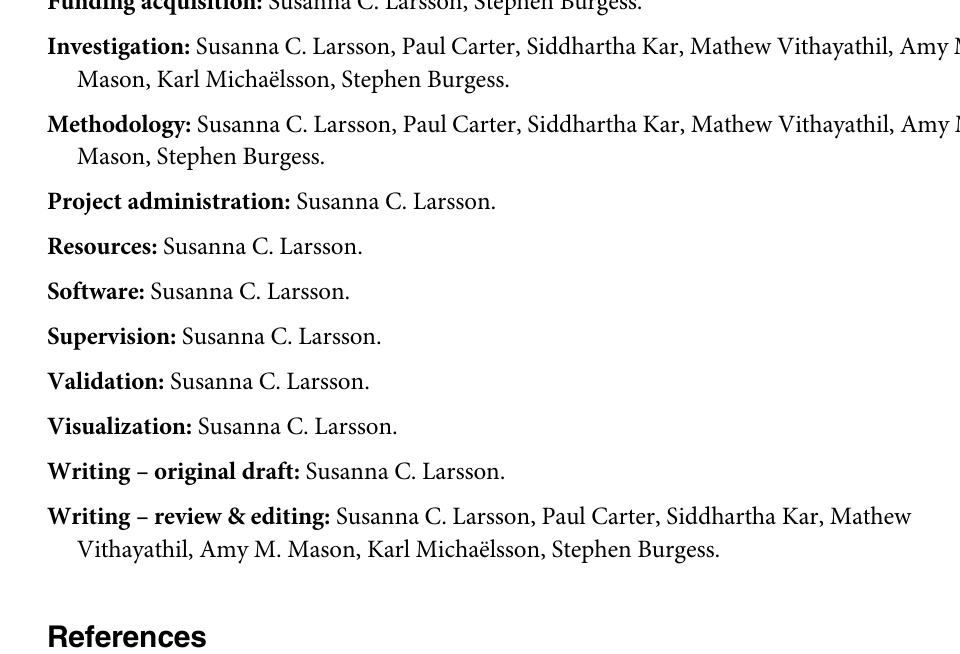
S5 Table. Associations of genetically predicted alcohol consumption with site-specific can- cers in the primary inverse-variance weighted analysis and in sensitivity analyses using other MR methods. MR, mendelian randomisation. S6 Table. Associations of genetically predicted alcohol consumption with subtypes of lung cancer, breast cancer, non-Hodgkin lymphoma, and leukaemia in MR analyses. MR, men- delian